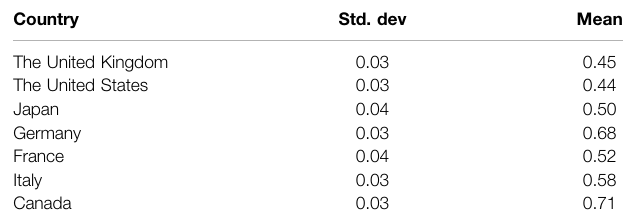
TABLE 5 | Mean and standard deviation of sensitivity score. Country Std.